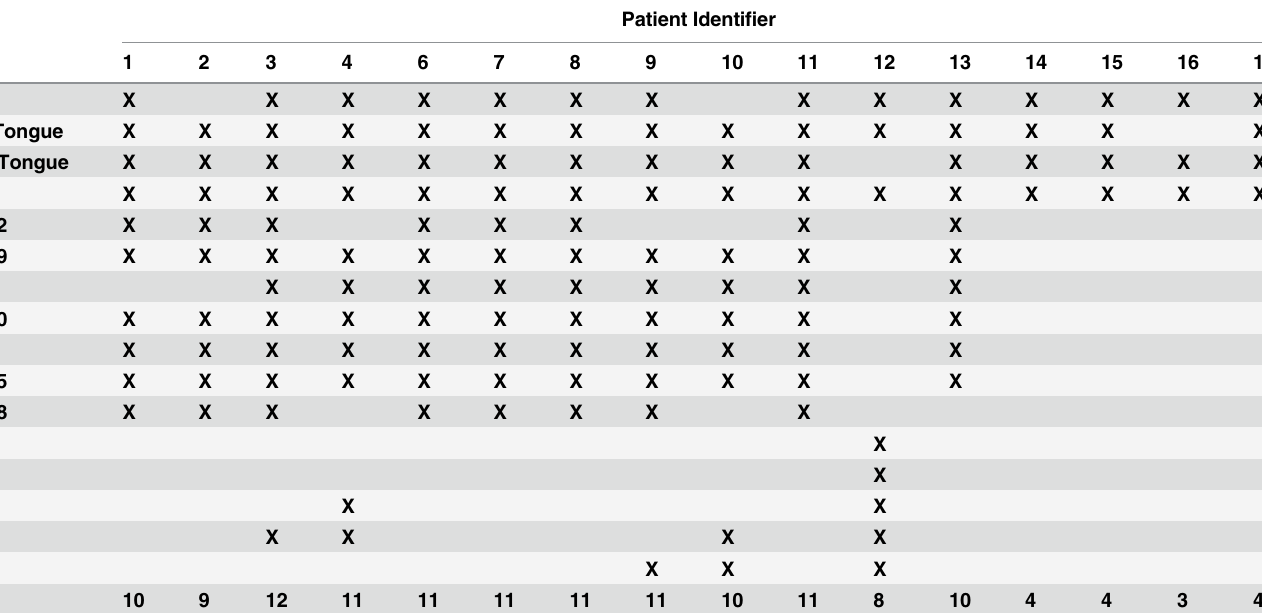
Table 5. Patient Sequencing Data a